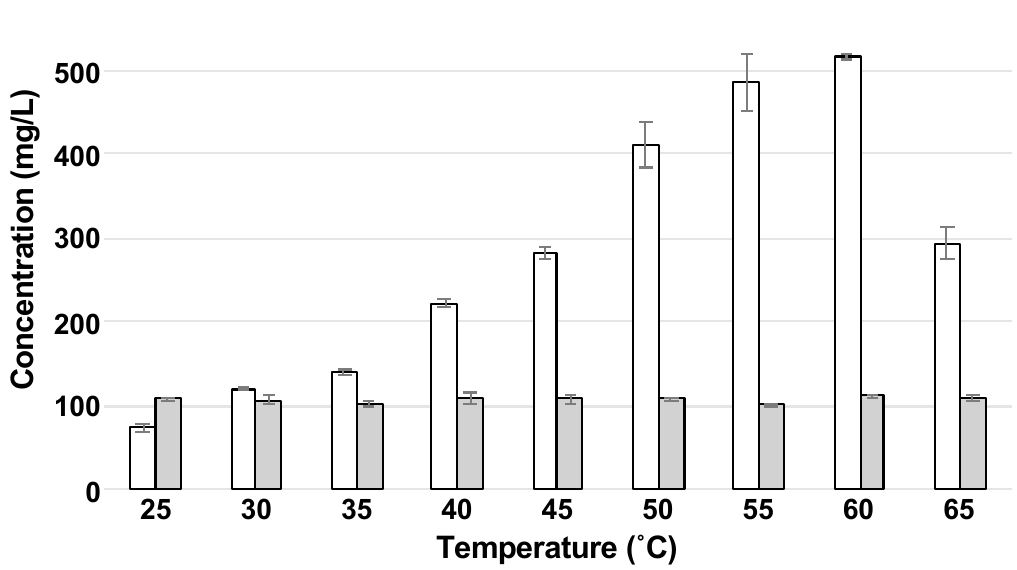
Figure 1. Effect of temperature on enzymatic hydrolysis. The concentrations of glucose and xylose are indicated as white and gray bars, respectively. Error bars indicate SE ( n = 3) .